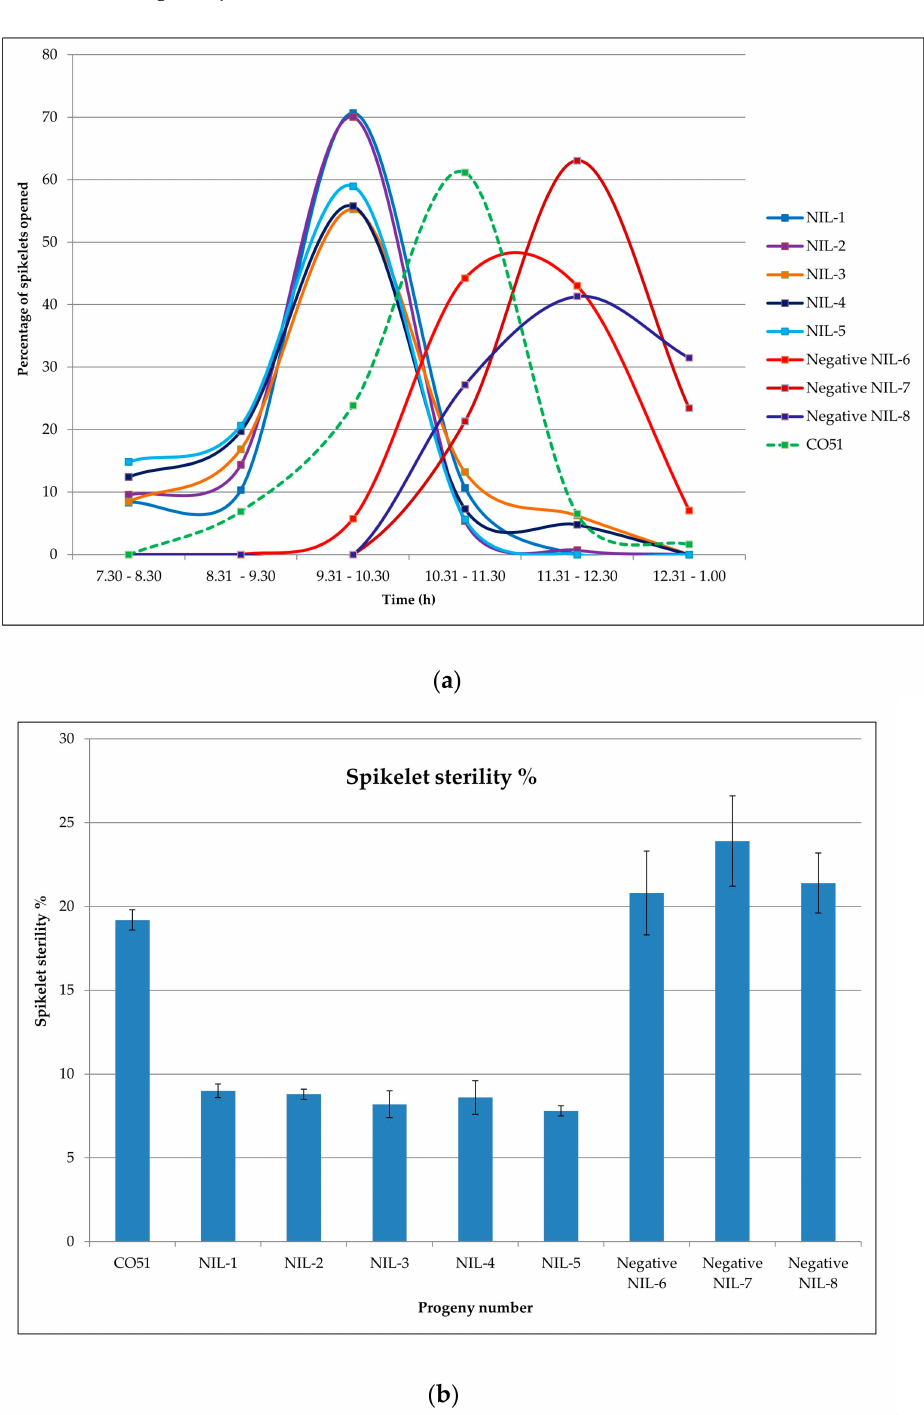
Figure 5. Flowering pattern and spikelet sterility of CO 51 NILs harboring qEMF3 during summer 2019; ( a ). Flowering pattern; ( b ). Spikelet sterility